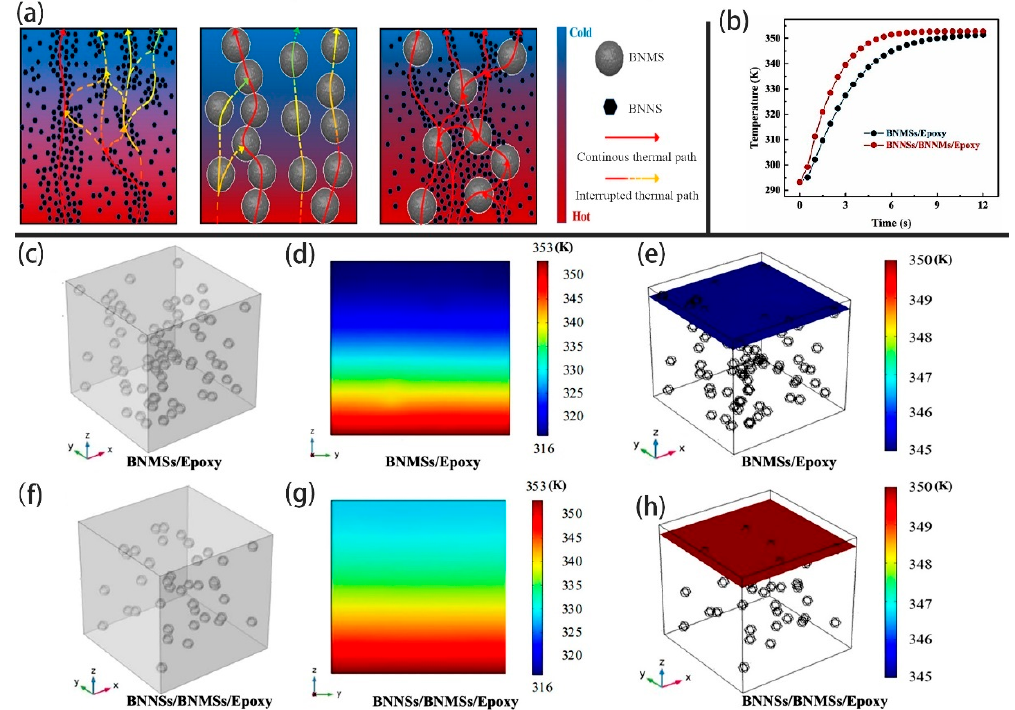
Figure 27. ( a ) Thermal-conduction pathways in the composites. ( b ) The simulation result of surface temperature–time profile of epoxy filled with BNMSs and BNNSs / BNMSs. ( c , d ) BNMSs / epoxy and ( f , g ) BNNSs / BNMSs / epoxy composites simulation model and temperatures profile for the longitudinal sections, respectively. ( e ) The BNMSs / epoxy and ( h ) BNNSs / BNMSs / epoxy composites temperatures at the same cross-sectional position (reproduced with permission from [94]).